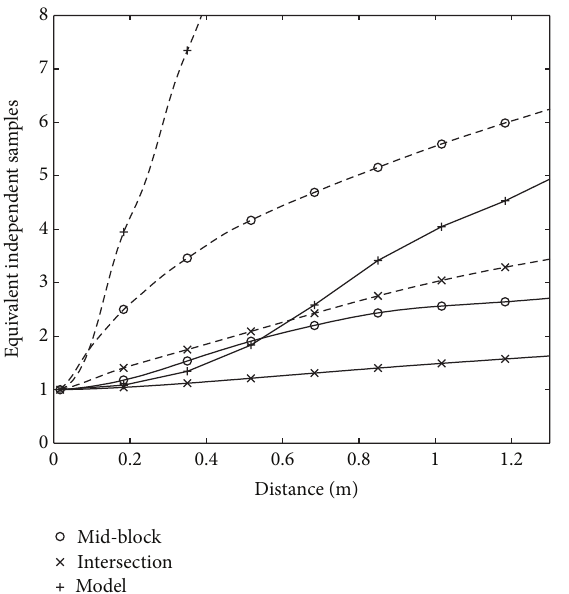
Figure 4: Average equivalent independent samples for time- correlated data at 30km/hr for 370 MHz (solid lines) and 2 GHz (dashed lines) and for the Clarke Doppler model (5).